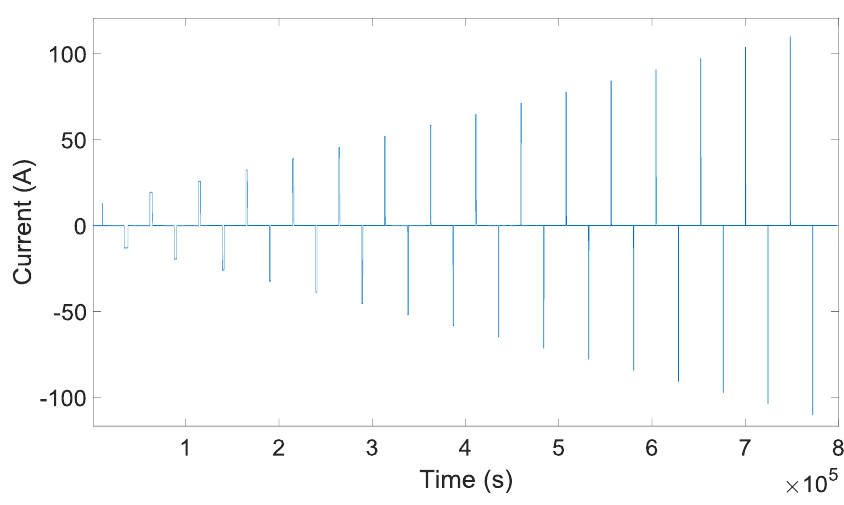
Figure 9. Battery current in function of time.